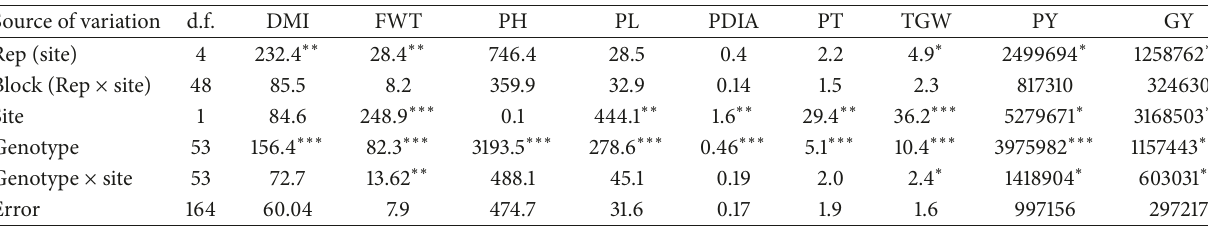
Table 2: Mean squares for studied traits across